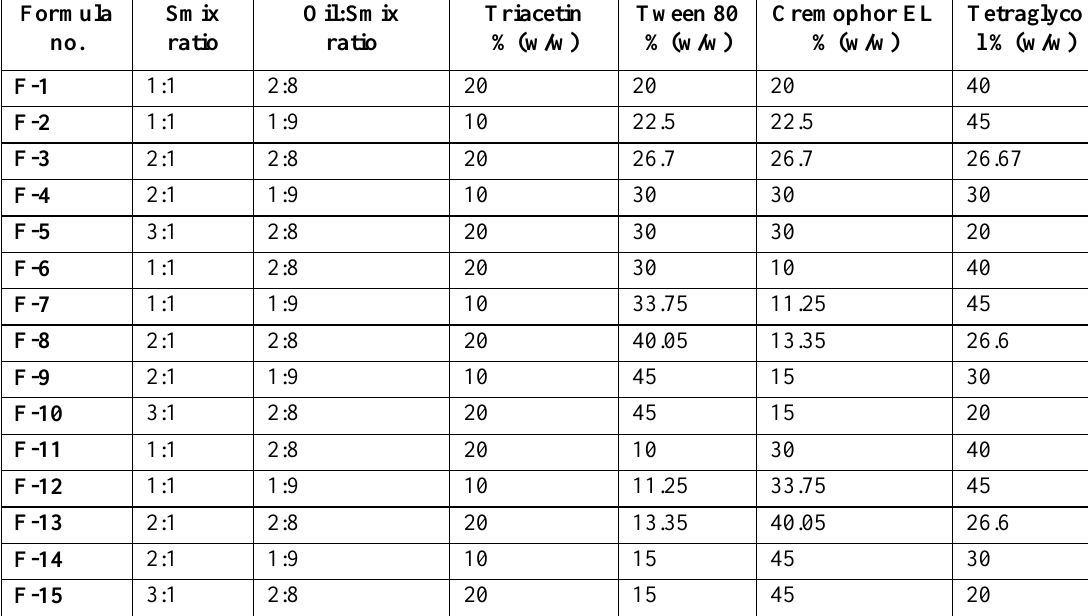
Table 1.Components and percentage of SEDDS of